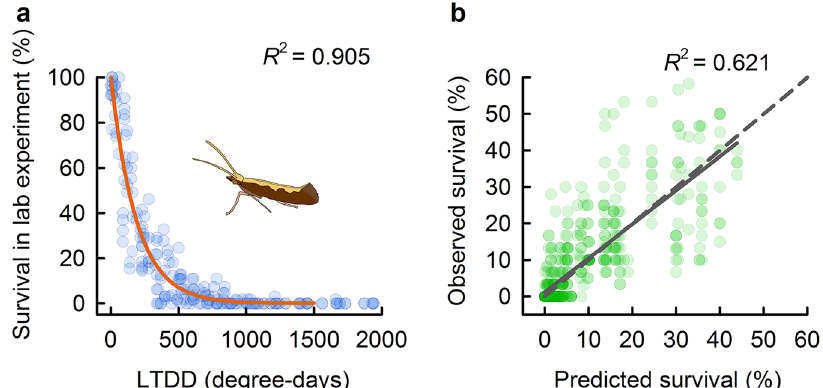
Fig. 2 Optimal winter survival model and fi eld validation. a Optimal winter survival model of diamondback moth with low-temperature degree-days (LTDD) ( n = 220). b Relationship between model predictions vs. fi eld observations of winter survival ( n = 556). R 2 indicates the variability explained by the regression model. Blue and green circles represent the survival rates of diamondback moth in laboratory experiments and fi eld investigations, respectively. The red line represents model predictions and the grey solid line represents the linear regression between LTDD model predicted and observed survival under natural conditions across geographically distinct sites (grey dashed line indicates the 1:1 reference line). Source data are provided as a Source data fi le.